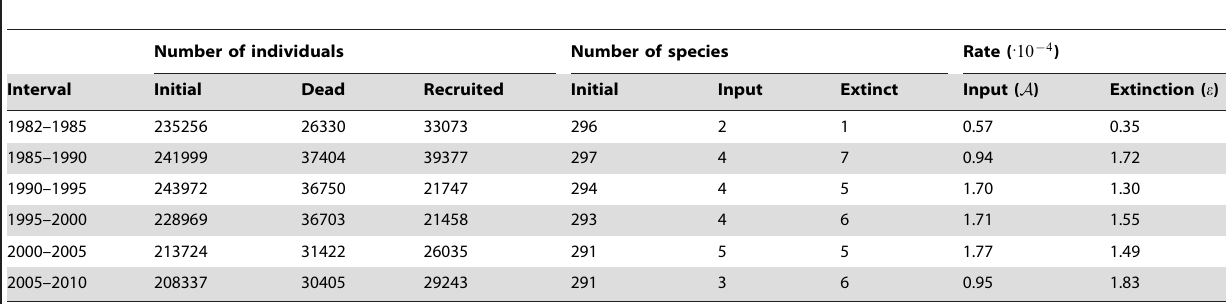
Table 1. Rates of species turnover during six census intervals in the Barro Colorado 50-ha plot.